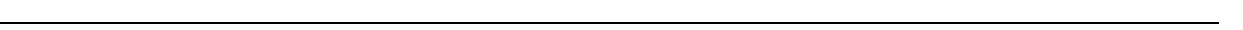
Fig. 3 NKp30 interaction with β -1,3-glucan revealed by AFM. a Representative force – distance (F – D) curves of YT cell binding to β -1,3-glucan. A single YT cell was attached to the cantilever tip. Mannan, media, β -1,3-glucan, or S. cerevisiae were coated on poly- L -lysine-treated glass. Peak downward de fl ection is the force of disruption. b Binding forces of YT cells to β -1,3-glucan vs. controls. A single YT cell was brought into contact and was detached from the matrix 20 – 30 times. At least three spots on the glass were tested per YT cell. Left panel: maximum binding forces from each valid contact over time. Right panel: average binding forces of YT cells to β -1,3-glucan, mannan, and blank glass control. c Binding forces of YT cell to β -1,3-glucan vs. H7-B6, and pustulan. A single YT cell was brought into contact and was detached from the matrix multiple times. Three to six areas on the coated glass were tested per YT cell. d F – D curves of C . neoformans binding to YT cells. A single B3501 cell was fi xed to a cantilever tip, and YT cells were adhered to either uncoated or poly- L - lysine glass. Left panel: binding of untreated C . neoformans strain B350, middle panel binding of caspofungin-treated, β -1,3-glucan - de fi cient C . neoformans (B3501 Δβ − glucan ), right panel average forces of untreated B3501 and B3501 Δβ -glucan . e Binding forces of β -1,3-glucan-coated beads to wild type vs. siRNA- NKp30-treated YT cells. β -1,3-glucan-coated beads ( β -1,3-GB) were glued to a cantilever, and the cells were adhered to a poly- L -lysine-coated ibidi dish. f Representative F – D curves of binding forces of polystyrene beads conjugated with or without β -1,3-glucan to recombinant NKp30 (right panel) vs. control glass surface (left panel). g Accumulated binding forces of beads conjugated with or without β -1,3-glucan to NKp30 or controls (left panel); average binding forces of beads conjugated with or without β -1,3-glucan to NKp30 or controls (right panel), note change of scale on vertical axis. h Binding forces of β -1,3-glucan-coated beads ( β -1,3-GB) to recombinant Fc chimera NKp30 vs. recombinant Fc chimera CD28. All experiments were repeated two to four times on different days with similar results. Glucan β -1,3-glucan, glucan beads β -1,3-glucan-conjugated polystyrene beads, isotype control IgG, NKp30 polyclonal anti-NKp30 antibody. **, p < 0.01. Data were analyzed using one-way ANOVA b , c , g or T -test d , e , h . pN,